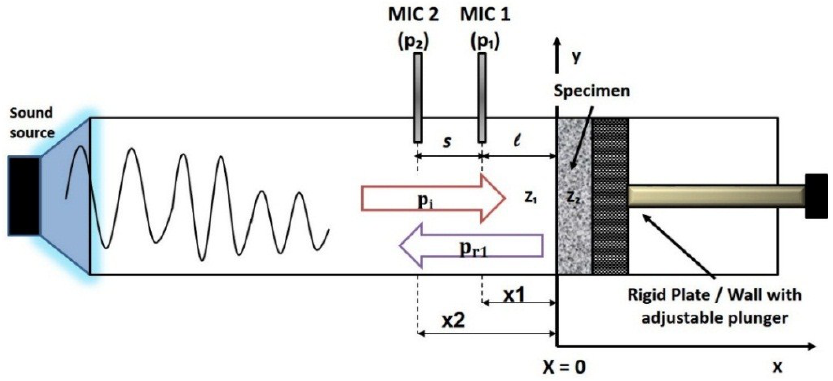
Figure 9. Schematic of plane wave generation for acoustic measurement using two-microphone impedance tube.